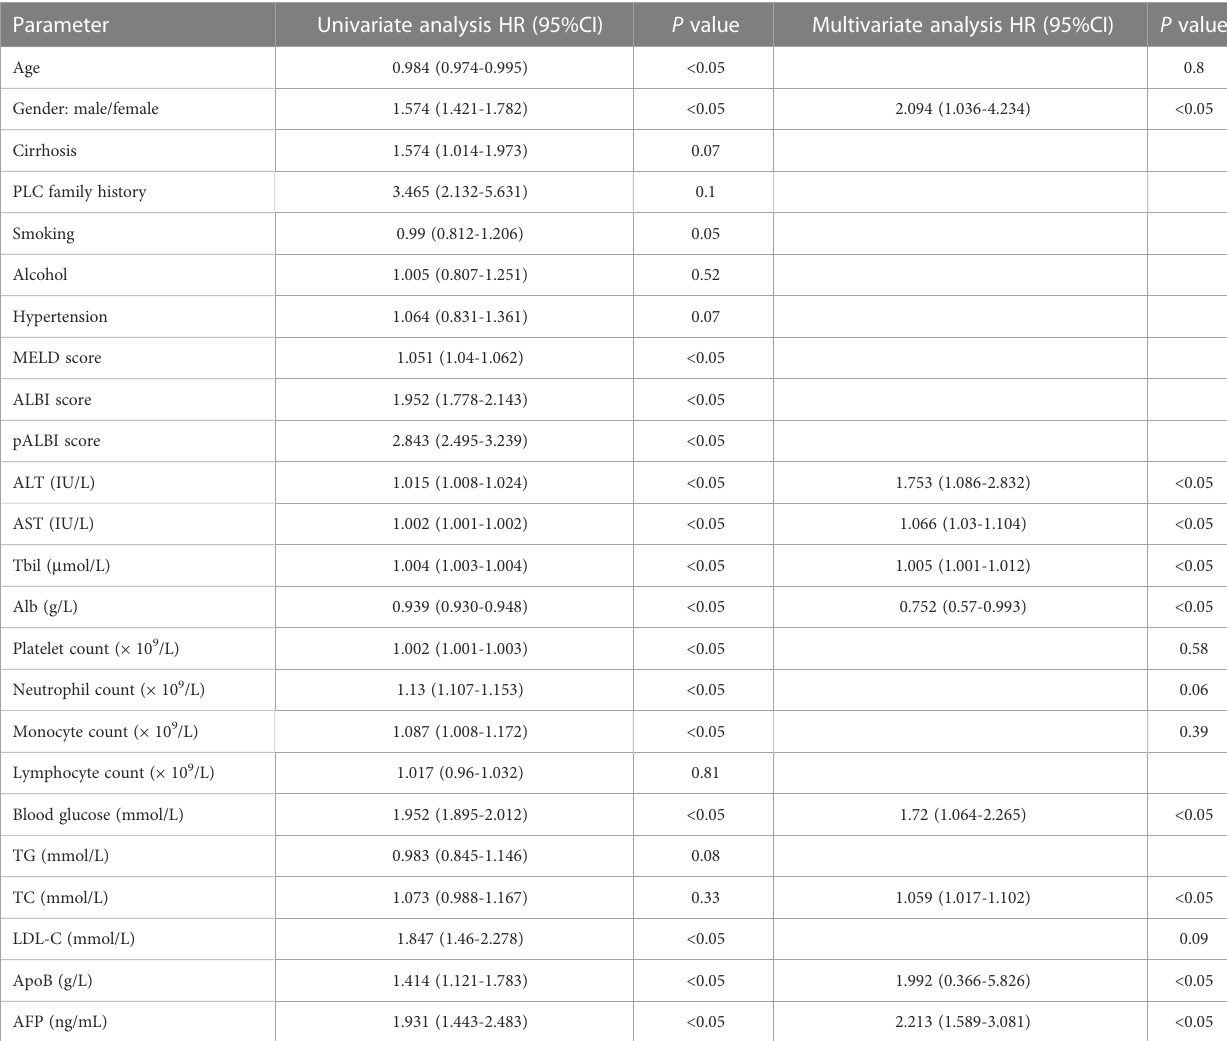
TABLE 2 Univariate and multivariate analysis of risk factors associated prognosis with PLC